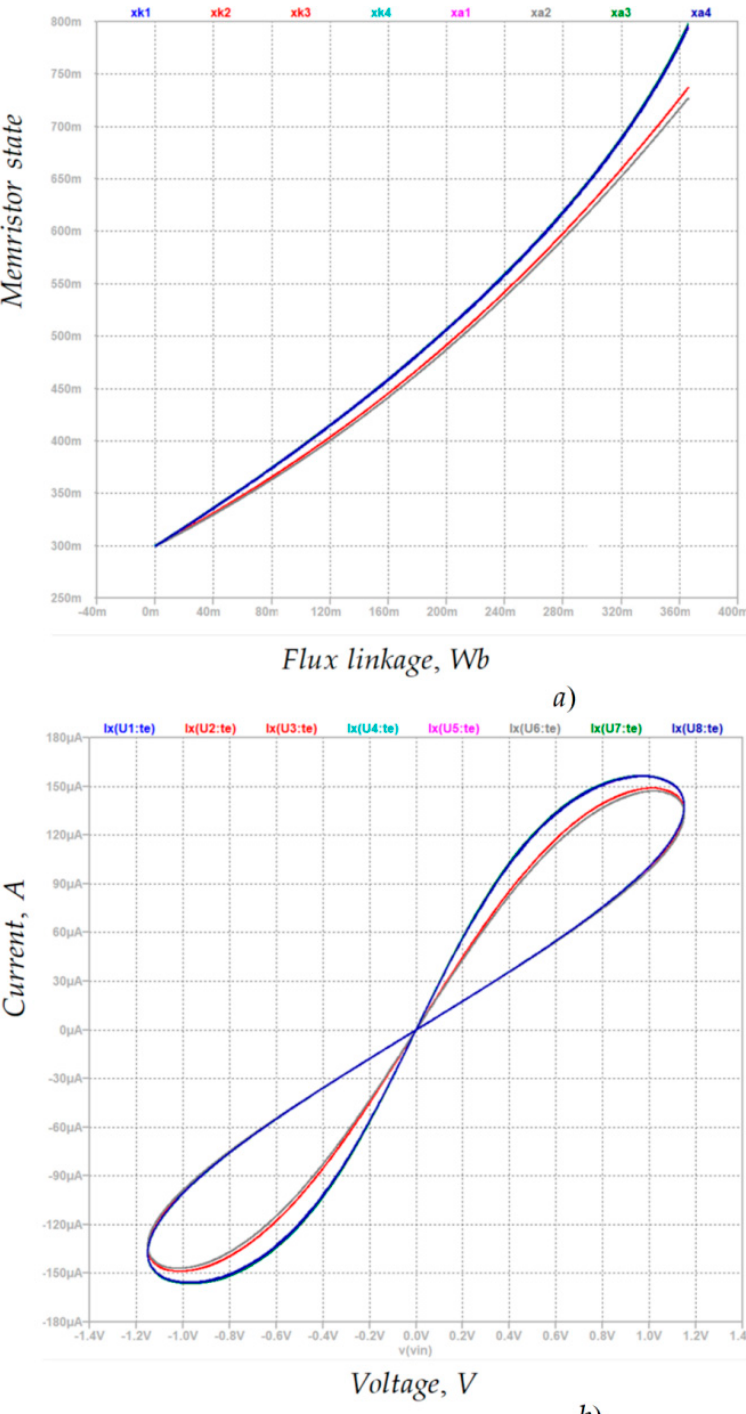
Figure 3. ( a ) State–flux relationships of the standard titanium dioxide memristor models K 1 , K 2 , K 3 , and K 4 , and the modified models A 1 , A 2 , A 3 , and A 4 , with a sinusoidal voltage magnitude of 1.15 V and a frequency of 1 Hz; ( b ) The corresponding current–voltage relationships of the considered titanium dioxide memristor